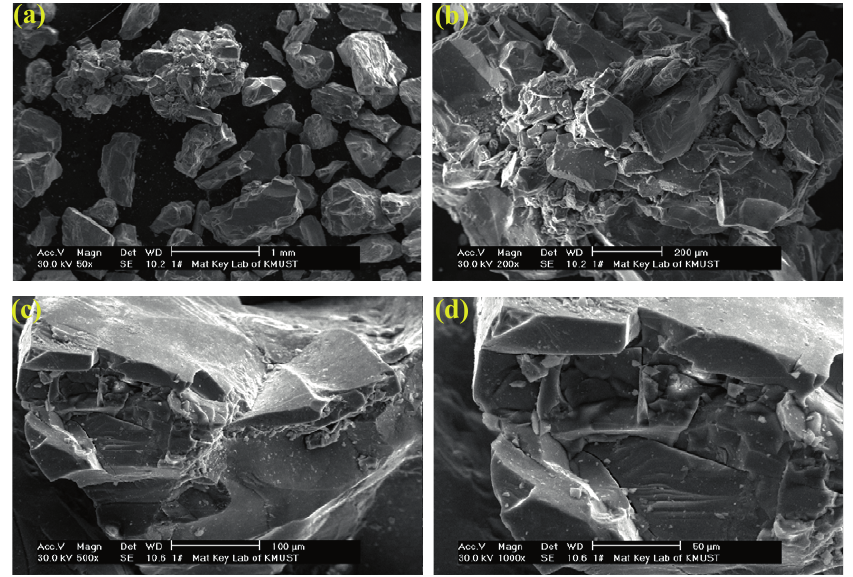
Figure 3. SEM image of titania slag at different magnifications (a)50 (cid:2) ; (b) 200 (cid:2) ; (c) 500 (cid:2) ; (d) 1000 (cid:2) . heat generation can be identified from the corresponding DSC curve.